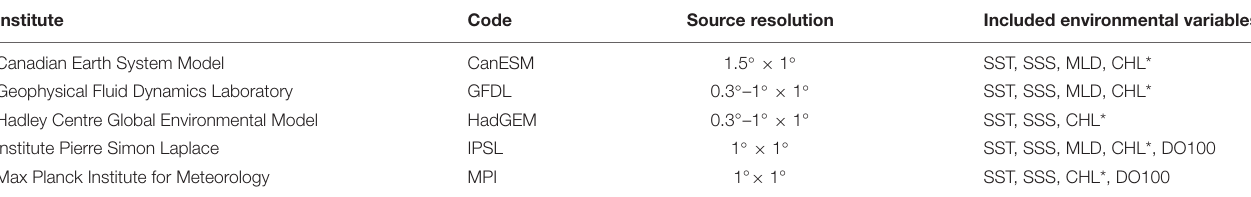
TABLE 1 | List of IPCC atmosphere-ocean general circulation models where the future environmental variables, including the sea surface temperature (SST, ◦ C), sea surface salinity (SSS, PSU), mixed layer depth (MLD, m), chlorophyll-a concentration (CHL, kg L − 1 ), and dissolved oxygen concentration under 100 m depth (DO100, mmol L − 1 ), were obtained to generate potential habitat maps of south Pacific albacore under ocean warming scenarios (RCP 4.5 and RCP